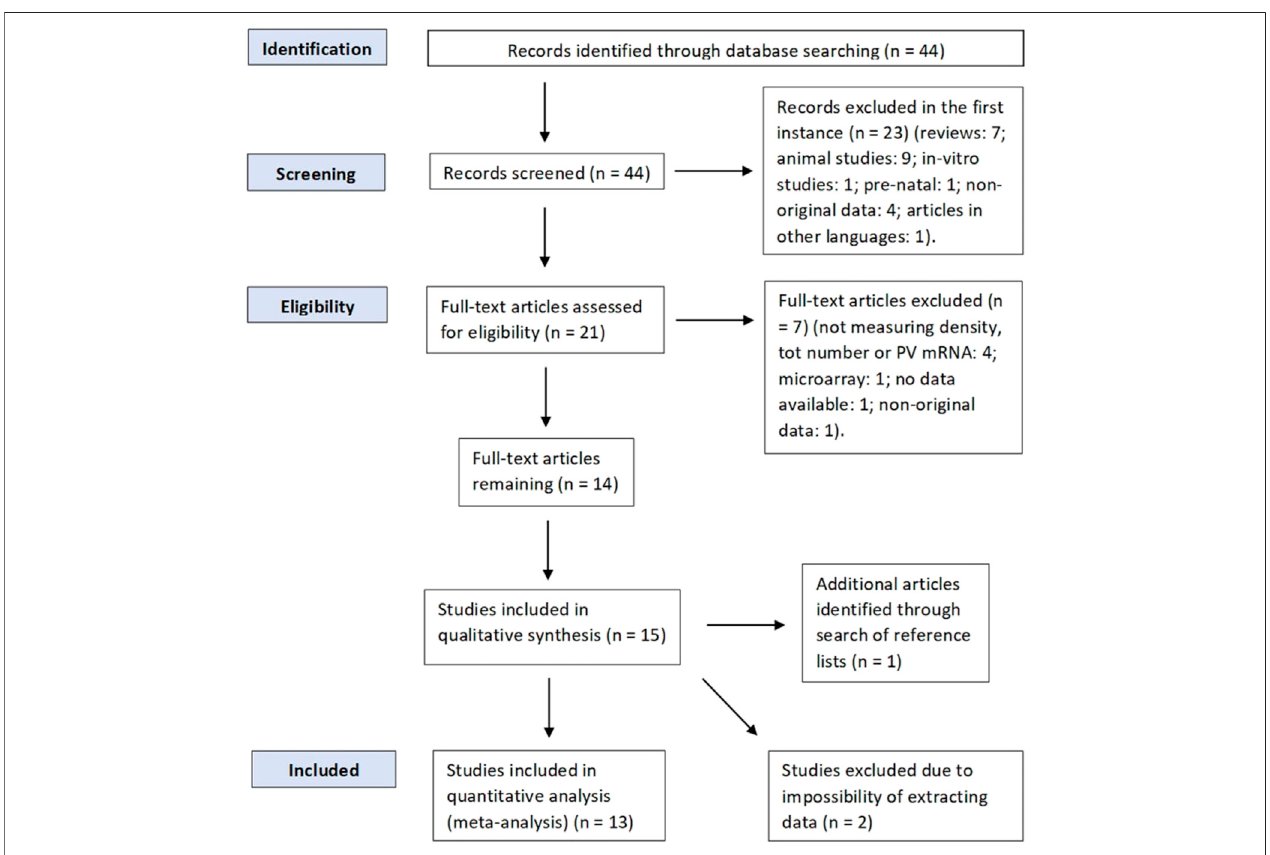
FIGURE 1 | Meta-analysis PRISMA fl ow